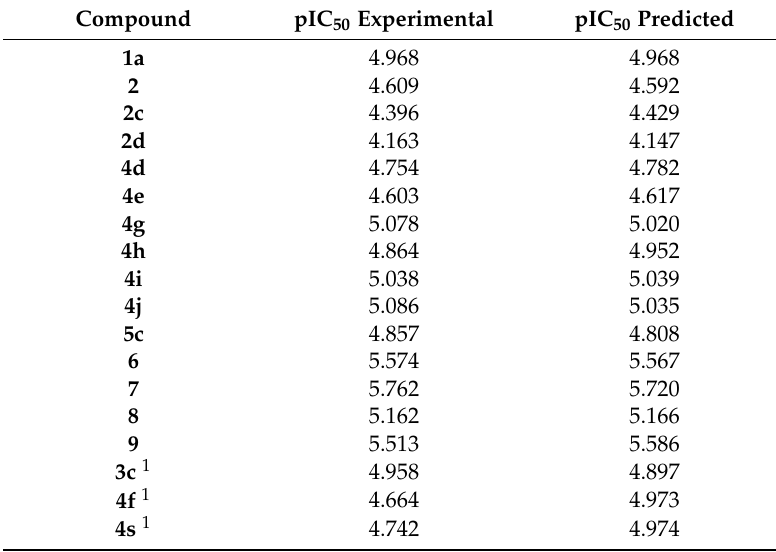
Table 2. Experimental and predicted values of pIC 50 obtained with the best comparative molecular field analysis (CoMFA) model for the training and test